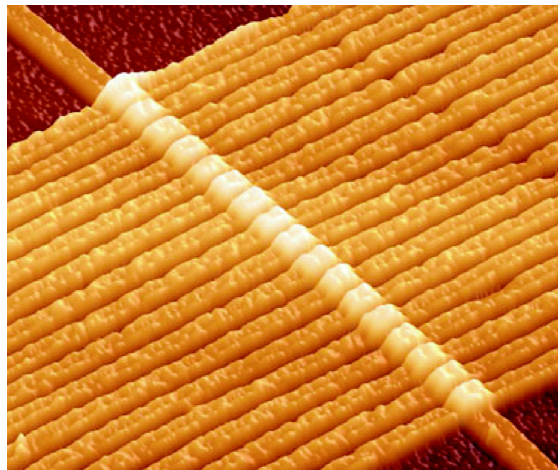
Fig. 1: The first realized memristor, produced in the HP lab. Seventeen nano-memristors are shown in parallel. (This image was produced by R. Stanley Williams of the HP lab and it is reproduced with permission from R. Stanley